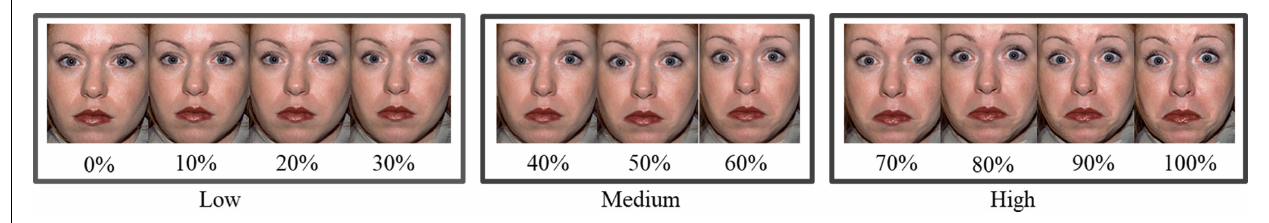
FIGURE 1 | Illustration of fearful facial expressions with different intensities. The image has been obtained from a public database with the publish permission.